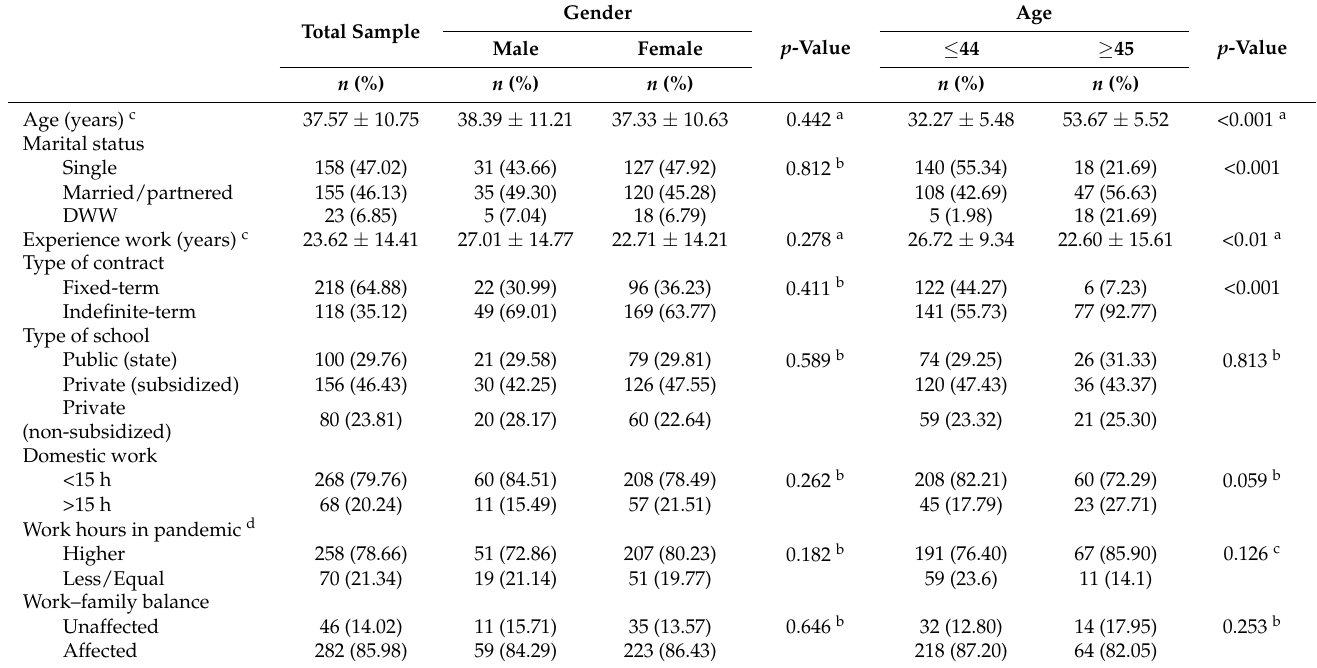
Table 1. Sociodemographic and working characteristics of Chilean teachers separated by gender and age group. Gender Total Sample p